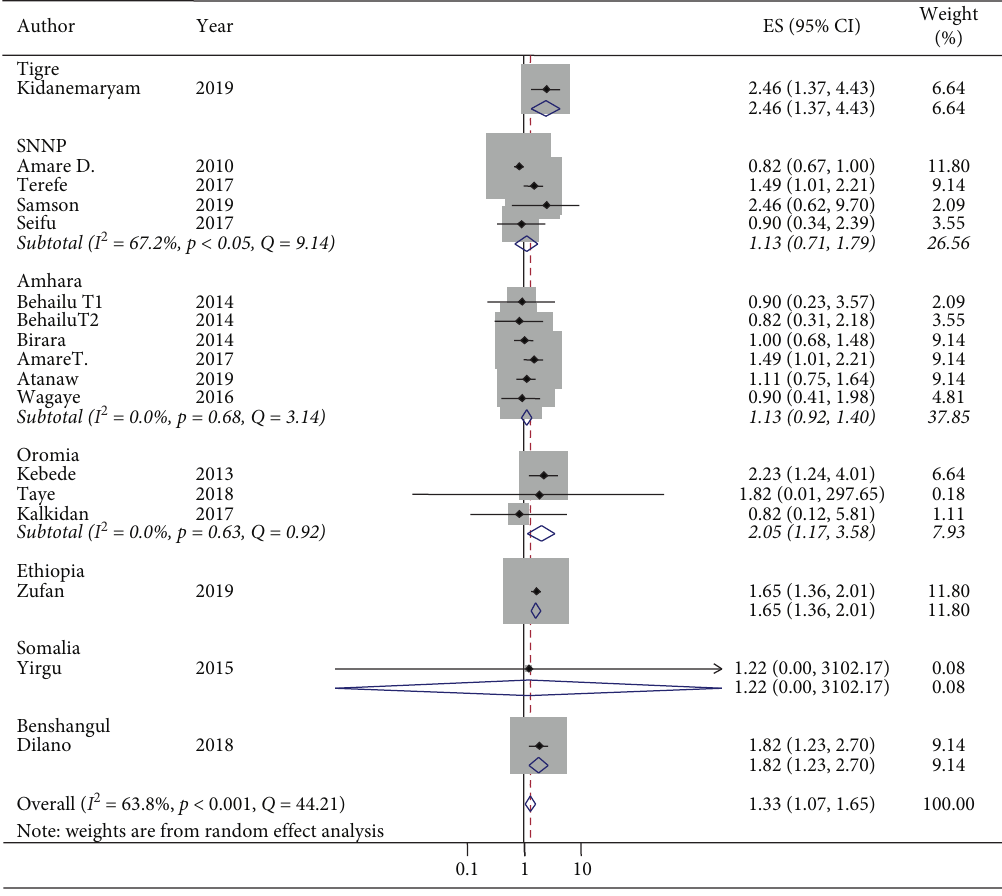
Figure 7: Subgroup analysis (by region) on the association of medium wealth index with stunting and its 95% CI in Ethiopia,